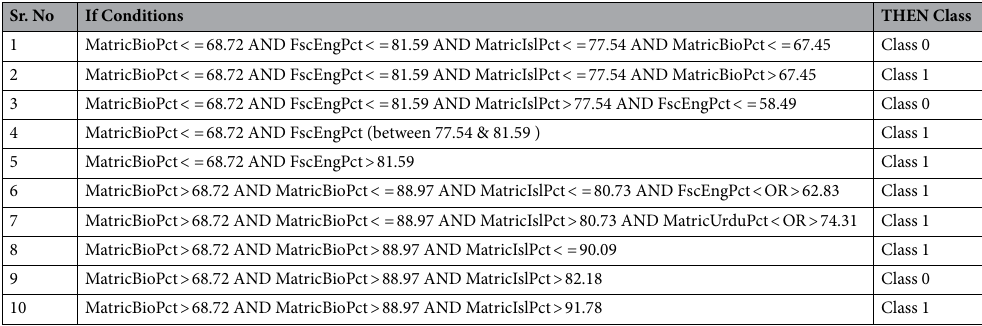
Table 3. Decision rules derived from a decision tree, where values are % marks in different